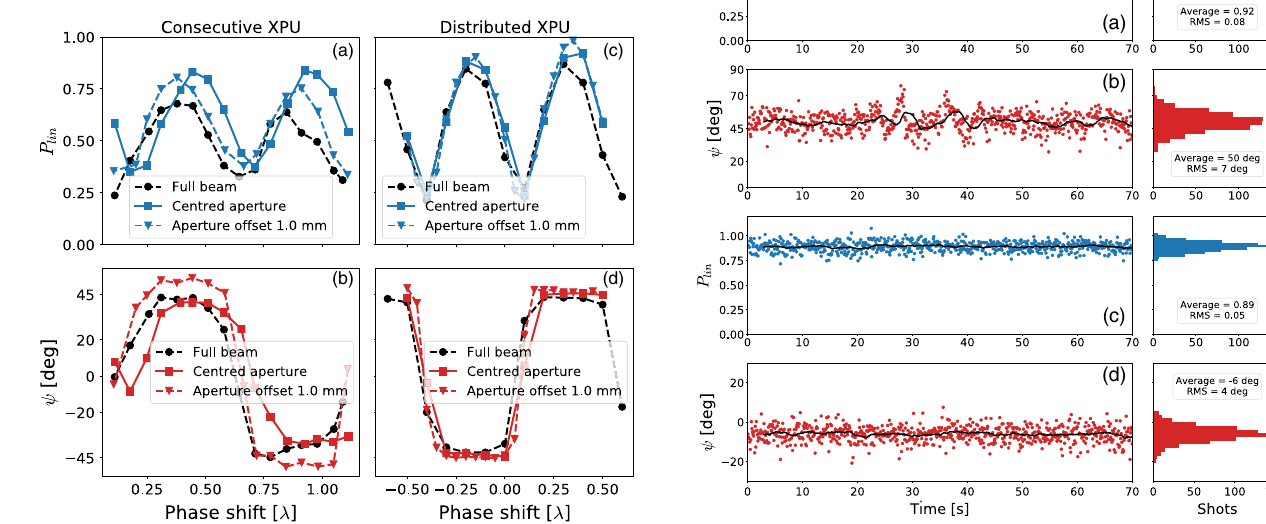
FIG. 13. Scan of the phase between the horizontal and vertical polarized fields for the consecutive (a, b) and distributed (c, d) XPU configurations. The degree (blue) and direction (red) of the linear polarization vector are reported as a function of the phase between the two fields. The curves correspond to full aperture (black) and two different positions of a 1 × 1 mm beam defining aperture. The data were obtained as the average of 40 consecutive shots at the same phase shift; the uncertainties are similar to Fig. 12 and are not shown for better clarity. For a comparison with the model predictions, see Fig. 9.